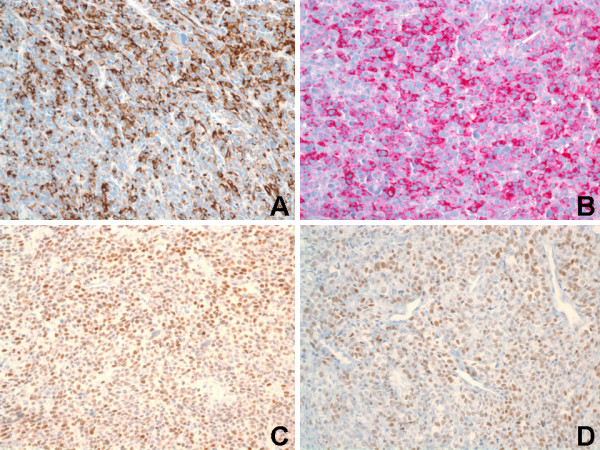
Immunohistochemical staining of renal tumor. (A) Both epithelioid and spindle cells were strong and diffusely positive for desmin (Immunoperoxidase, Original magnification ×200). (B) Both epithelioid and spindle cells were strong and diffusely positive for HMB-45 (Immunoperoxidase, Original magnification ×200). (C) Estrogen receptor (ER) immunostaining showed strong and diffuse nuclear reactivity in tumor cells (Immunoperoxidase, Original magnification ×200). (D) Progesterone receptor (PR) immunostaining showed strong and moderate nuclear reactivity in tumor cells (Immunoperoxidase, Original magnification ×200).